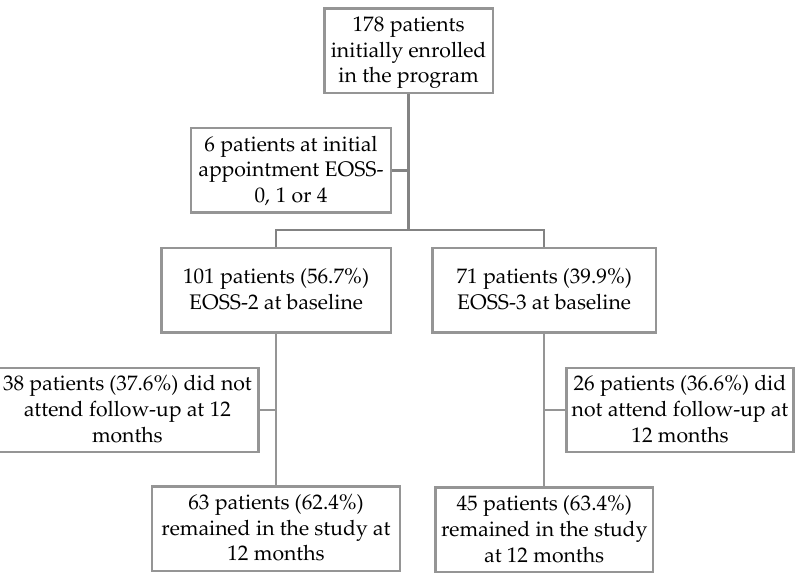
Figure 1. Flow diagram of subjects enrolled in the multidisciplinary weight management program at baseline and 12 months, by initial EOSS group.